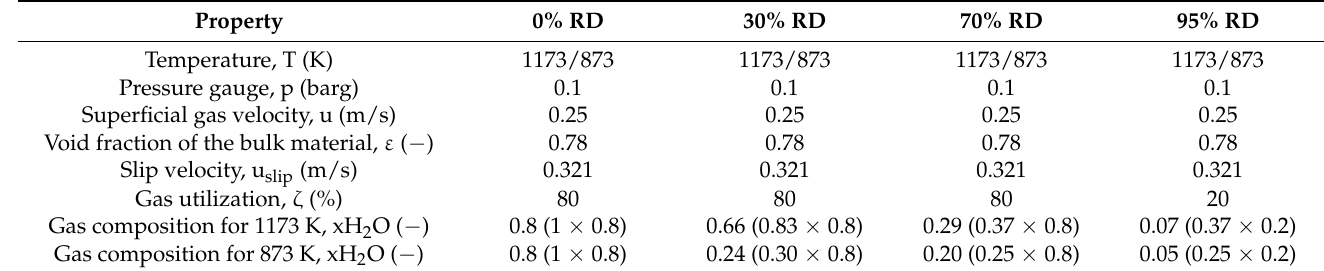
Table 2. Process conditions of the mathematical case